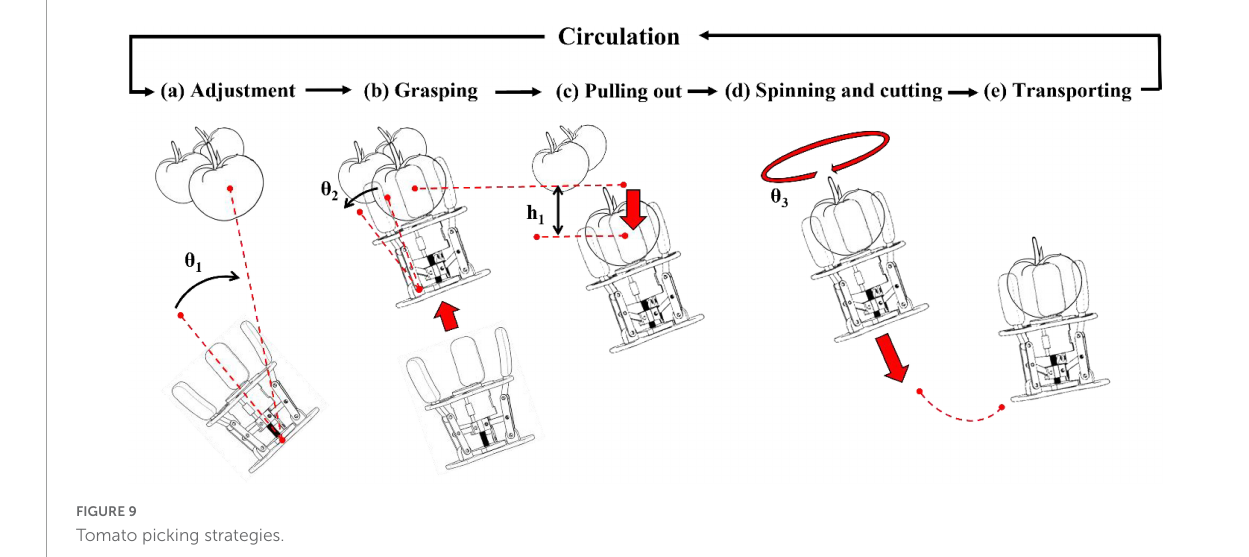
FIGURE9 Tomato picking strategies.